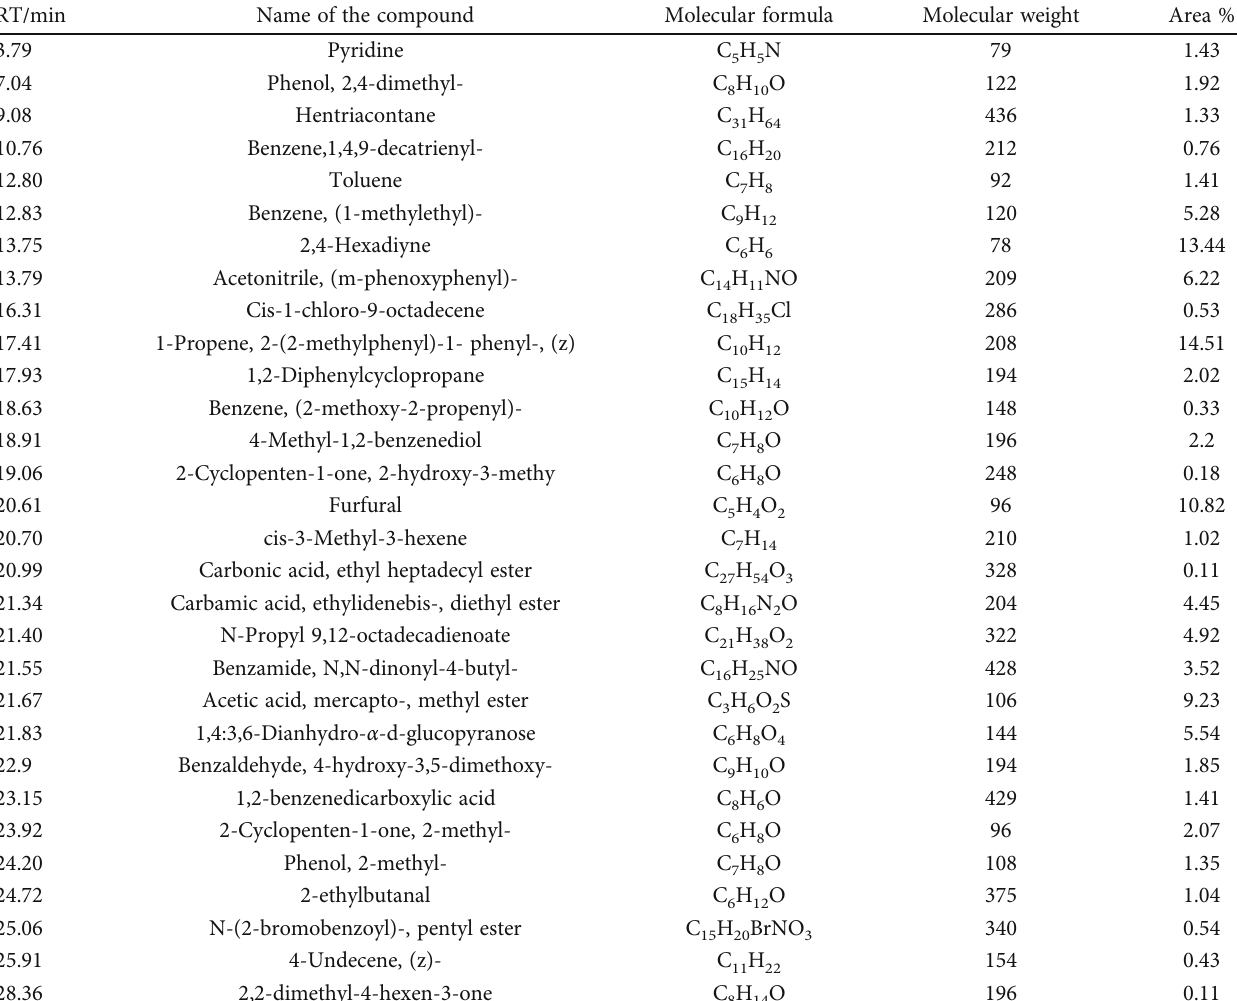
Figure 8: GC-MS spectrometry chromatograms of the copyrolysis oil. Table 4: GC-MS analysis of the copyrolysis